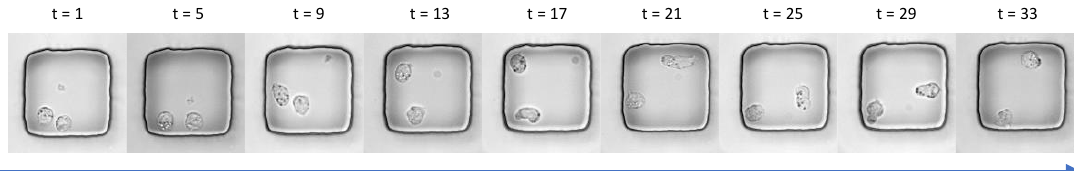
Figure 1. Representative phase contrast images of T lymphocytes within a nanowell. Each microscopy image contains 36 nanowells and is acquired at 35 timepoints ( t